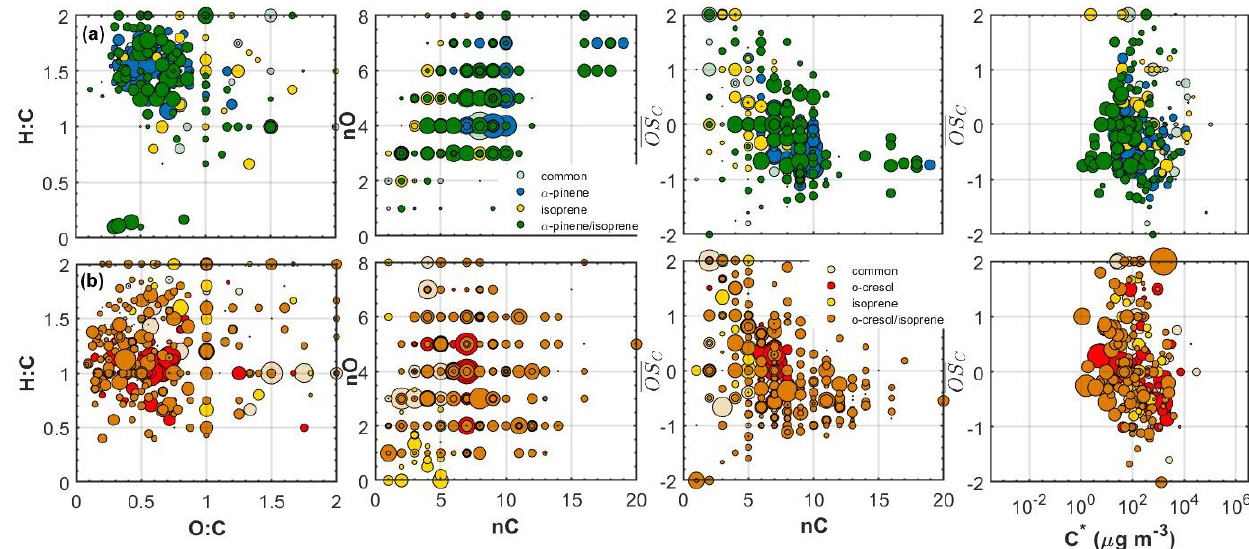
Figure 4. Hydrogen to carbon (H : C) by oxygen to carbon (O : C), number of carbon atoms (nC) by number of oxygen atoms (nO), carbon oxidation state (OSc) by nC and OSc by effective saturation concentration ( C ∗ ) of all the individual products identified in the (a) α - pinene/isoprene and (b) o -cresol/isoprene systems. The products that were uniquely found in the mixture are depicted with different colours. All the symbols are sized based on the particle-phase signal of each product in the